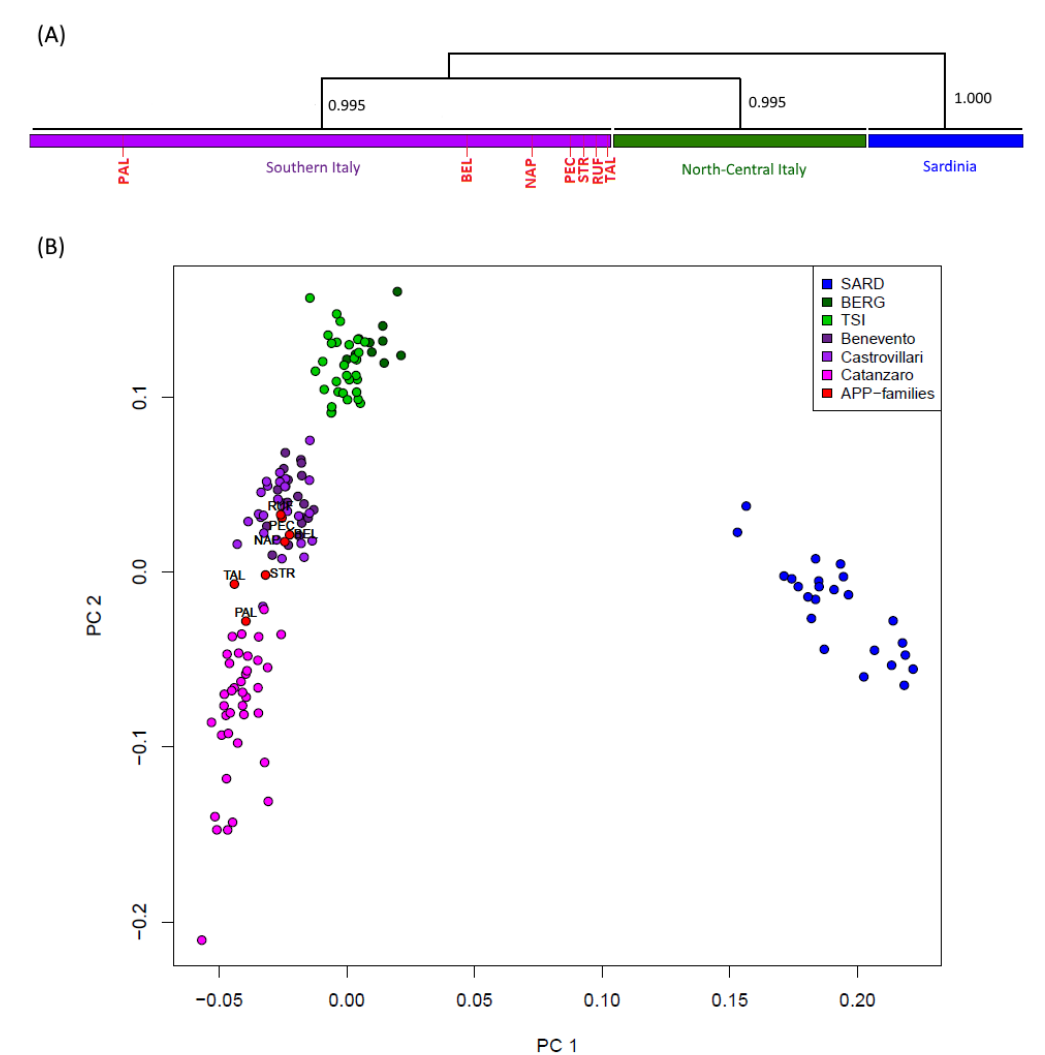
Figure 1. Genetic structure based on genome-wide haplotype-sharing pattern. ( A ) Schematic representation of fineSTRUCTURE hierarchical clustering showing the relationships among analyzed patients and the Italian healthy controls. Population clusters were defined by considering a posterior probability threshold higher than 90%. The full fineSTRUCTURE tree is shown in Supplementary Figure S3. ( B ) Principal component analysis based on chunkcount coancestry matrix, obtained from CHROMOPAINTER profiles; the top two components have been plotted in a scatterplot.